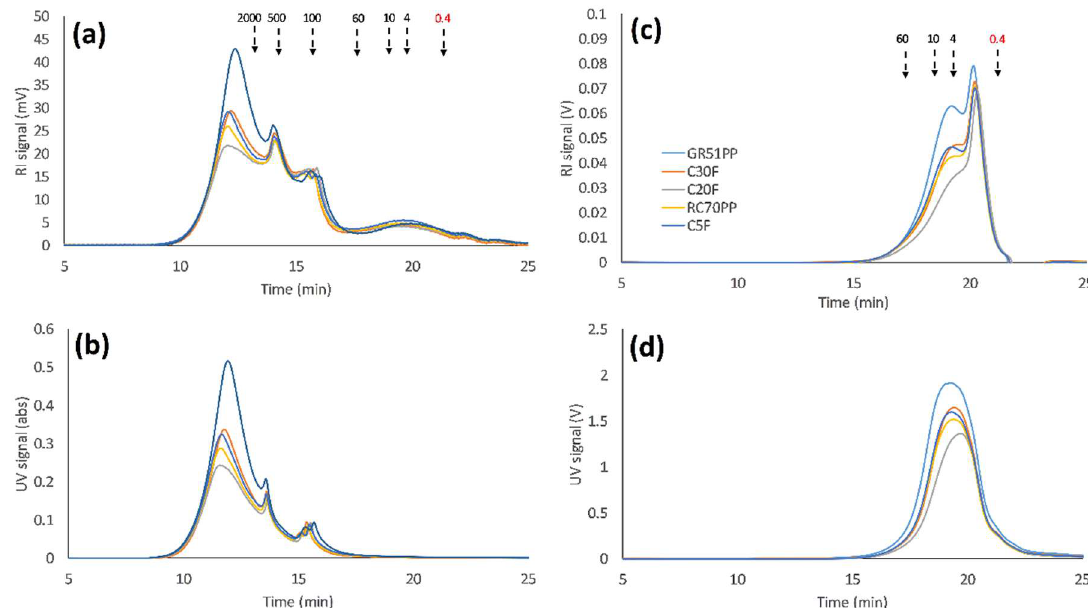
Figure 7. Size-exclusion chromatography of the volume-reduced retentates (90%) for all of the studied membranes; where ( a , b ) are the RI and UV detector response respectively using water as eluent. ( c , d ) are the RI and UV detector response respectively using 100 mM NaOH as eluent. Arrows point to the peak maximum of the various dextran standards, except for the lowest MW standard (0.4 kDa) which was PEG.